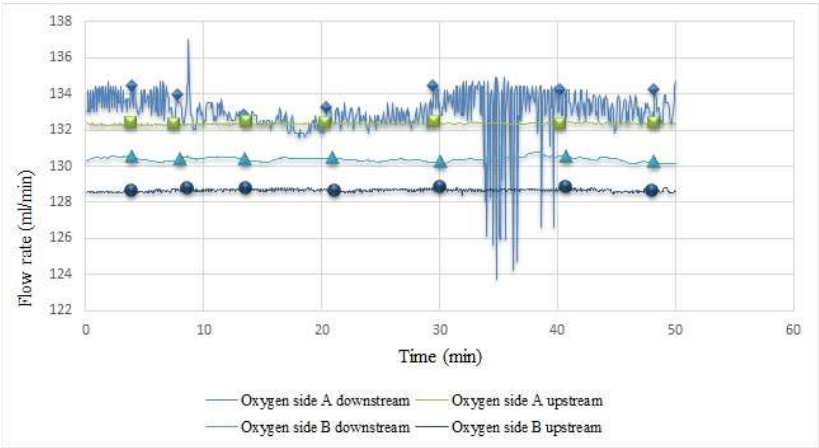
Figure 14. Internal flow measurement during proton battery stack charging.